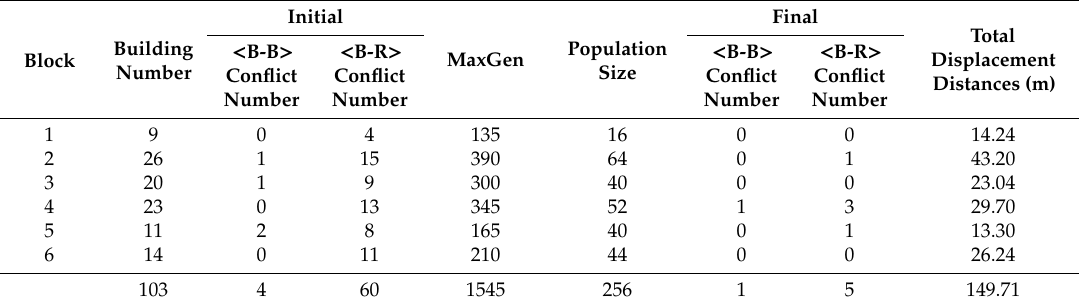
Figure 7. Comparison diagram. ( a ) Displacement result using the IGA (1:10,000); ( b ) Comparison result of the original data and displacement results based on the IGA (1:10,000). Table 4. Statistical information of the displacement results based on the